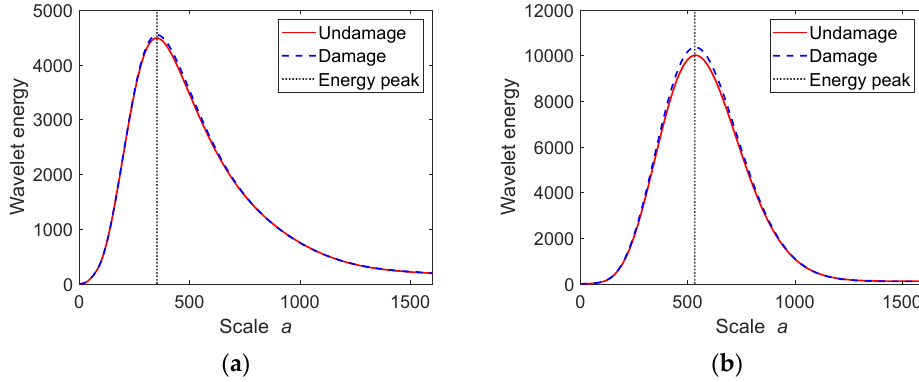
Figure 15. Wavelet energy with different vehicle mass. ( a ) ‘lighter’ vehicle; ( b ) ‘heavier’ vehicle.